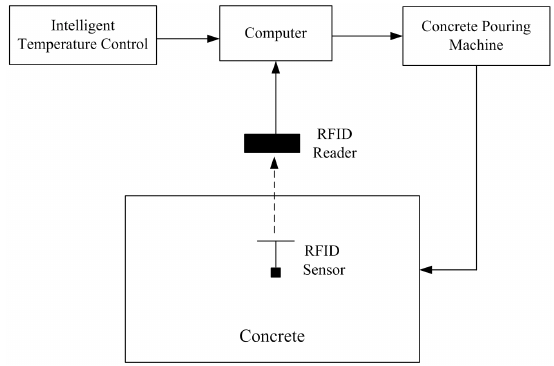
Figure 1. Proposed concrete-temperature monitoring method.